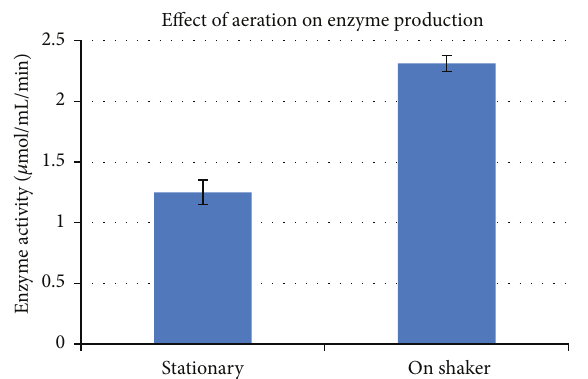
Figure 7: Effect of agitation on L-asparaginase production by Streptomyces ginsengisoli. Values are the means of three replicates ± SD.